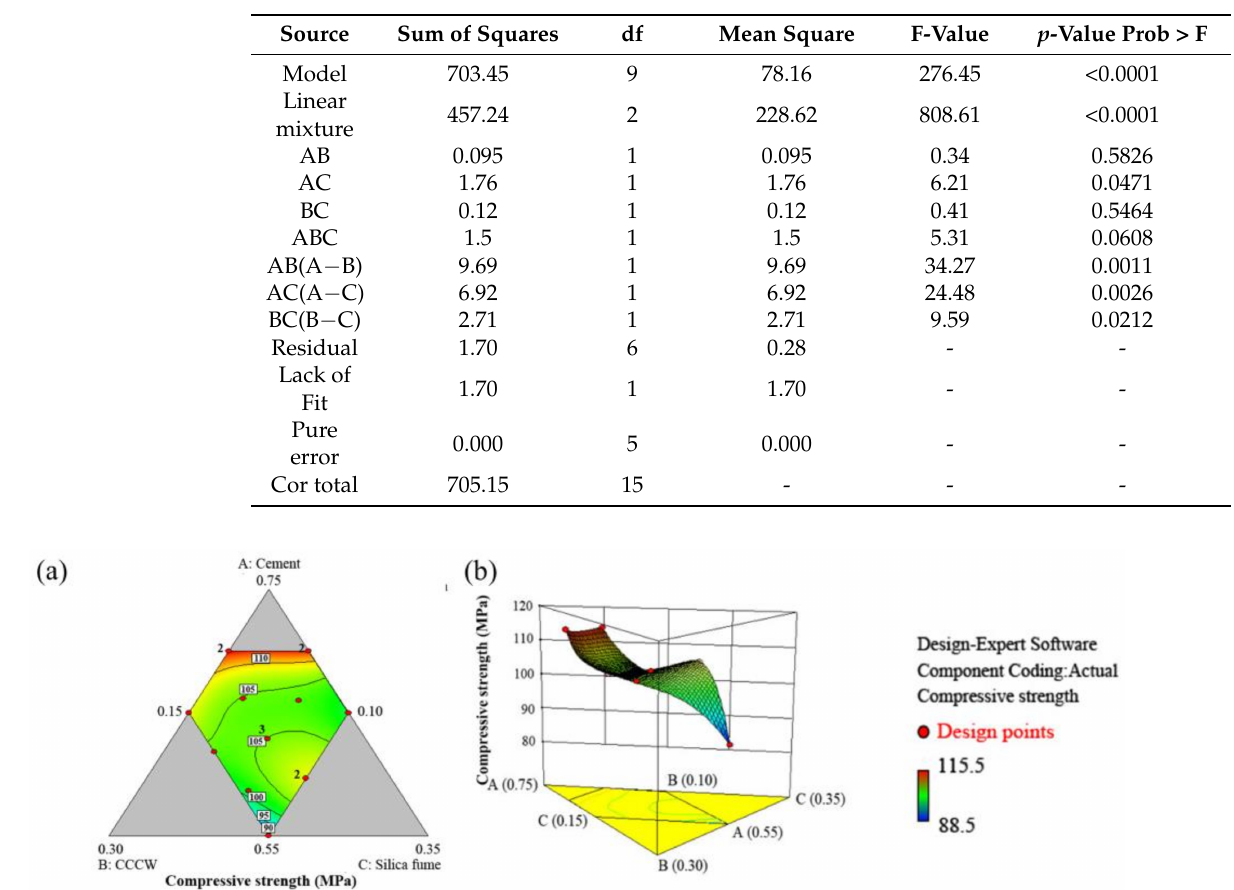
Table 7. Analysis of variance results of parameter interaction.